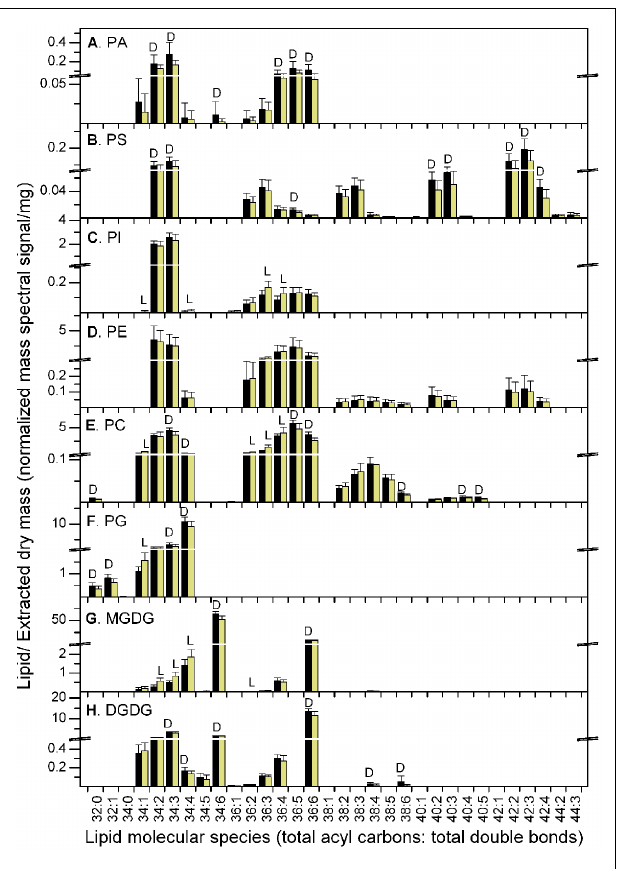
FIGURE 3 | Lipid molecular species at the end of the dark and light periods. The data are from Experiment 1. (A) PA, (B) PS, (C) PI, (D) PE, (E) PC, (F) PG, (G) MGDG, (H) DGDG.The black bars represent the levels at the end of the dark period and the light yellow bars represent the levels at the end of the light period.The “D” symbol indicates that the amount of normalized mass spectral signal per extracted dry mass was significantly higher ( p < 0.05) at the end of the dark period than at the end of the light period in this experiment, while the “L” symbol indicates that the amount of normalized mass spectral signal per extracted dry mass was significantly higher ( p < 0.05) at the end of the light period than at the end of the dark period. n = 20 for dark; n = 19 for light. Note the break in the y -axis and the change in scales above and below the break.